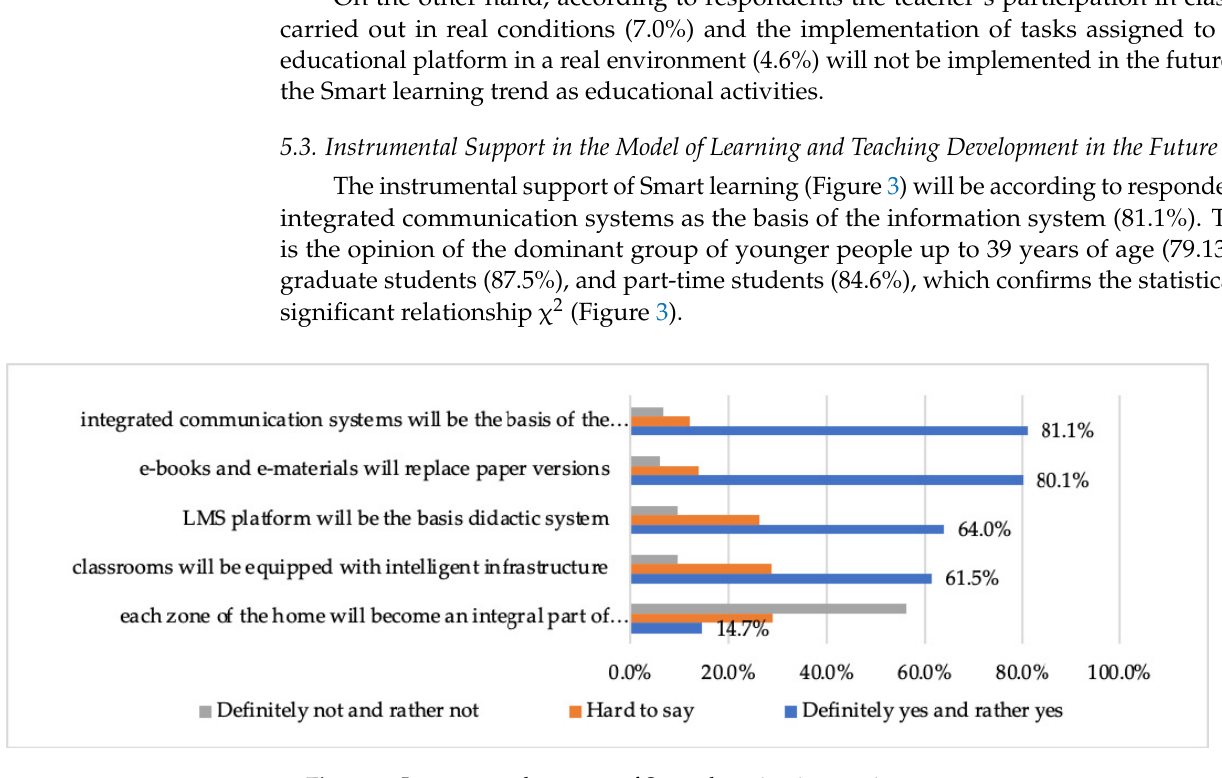
Figure 3. Instrumental support of Smart learning in practice.